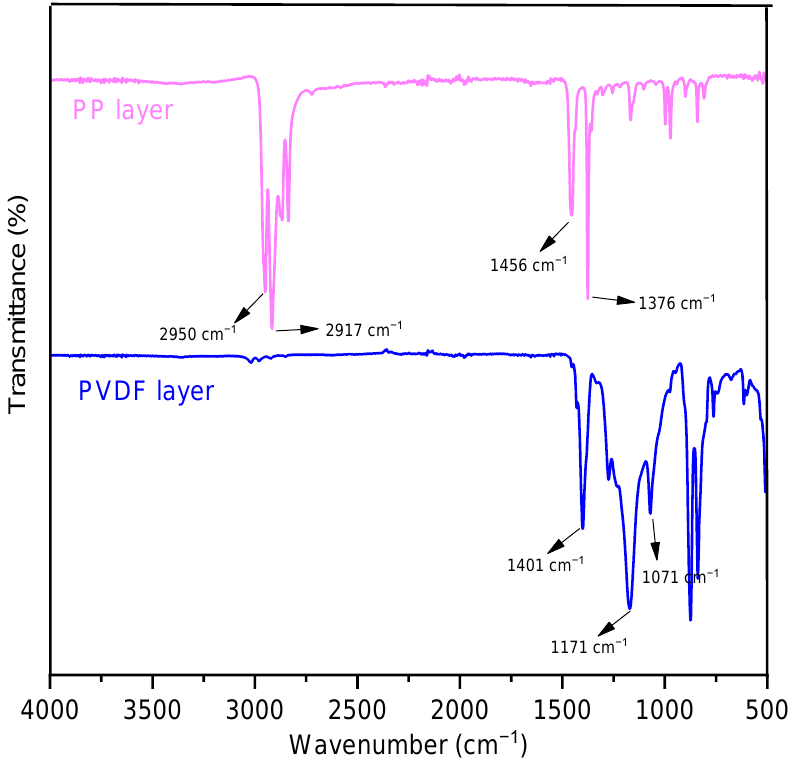
Figure 3. ATR-IR analysis of the composite filter.